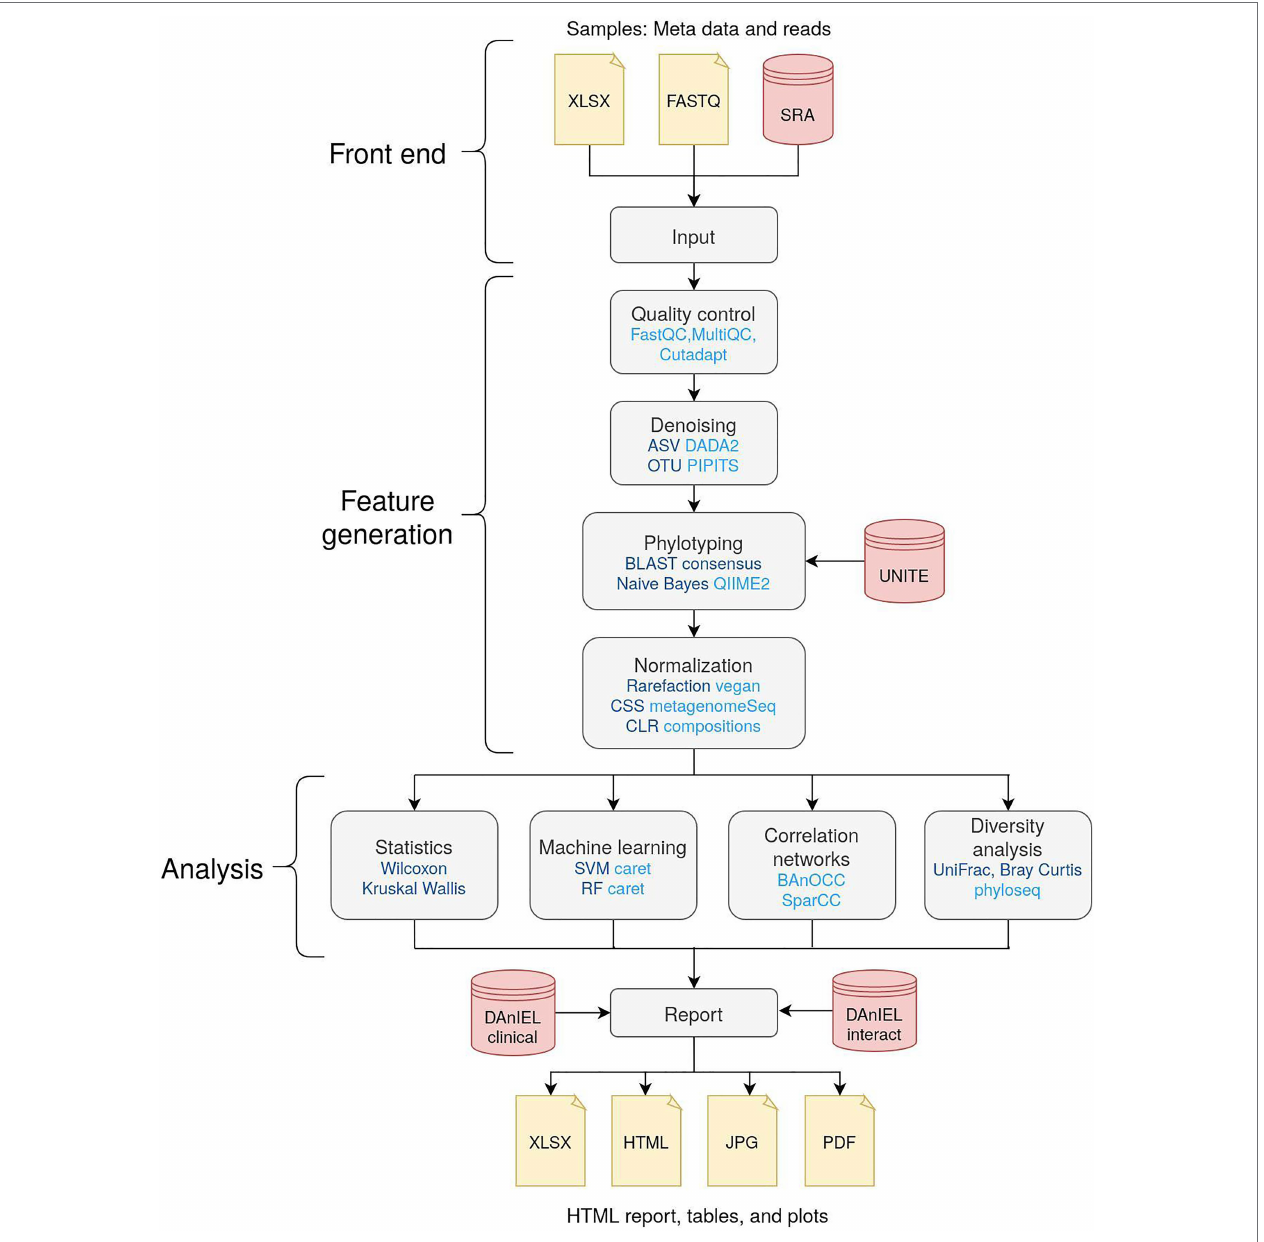
FIGURE 1 | Overview of the workflow of the DAnIEL web server. Methods and tools are shown in dark and light blue, respectively. Databases are shown in red. Feature generation and analysis are part of the back end. Taxa are augmented using our relational database of clinical samples (DanIEL clinical) and interactions reported in the literature (DanIEL